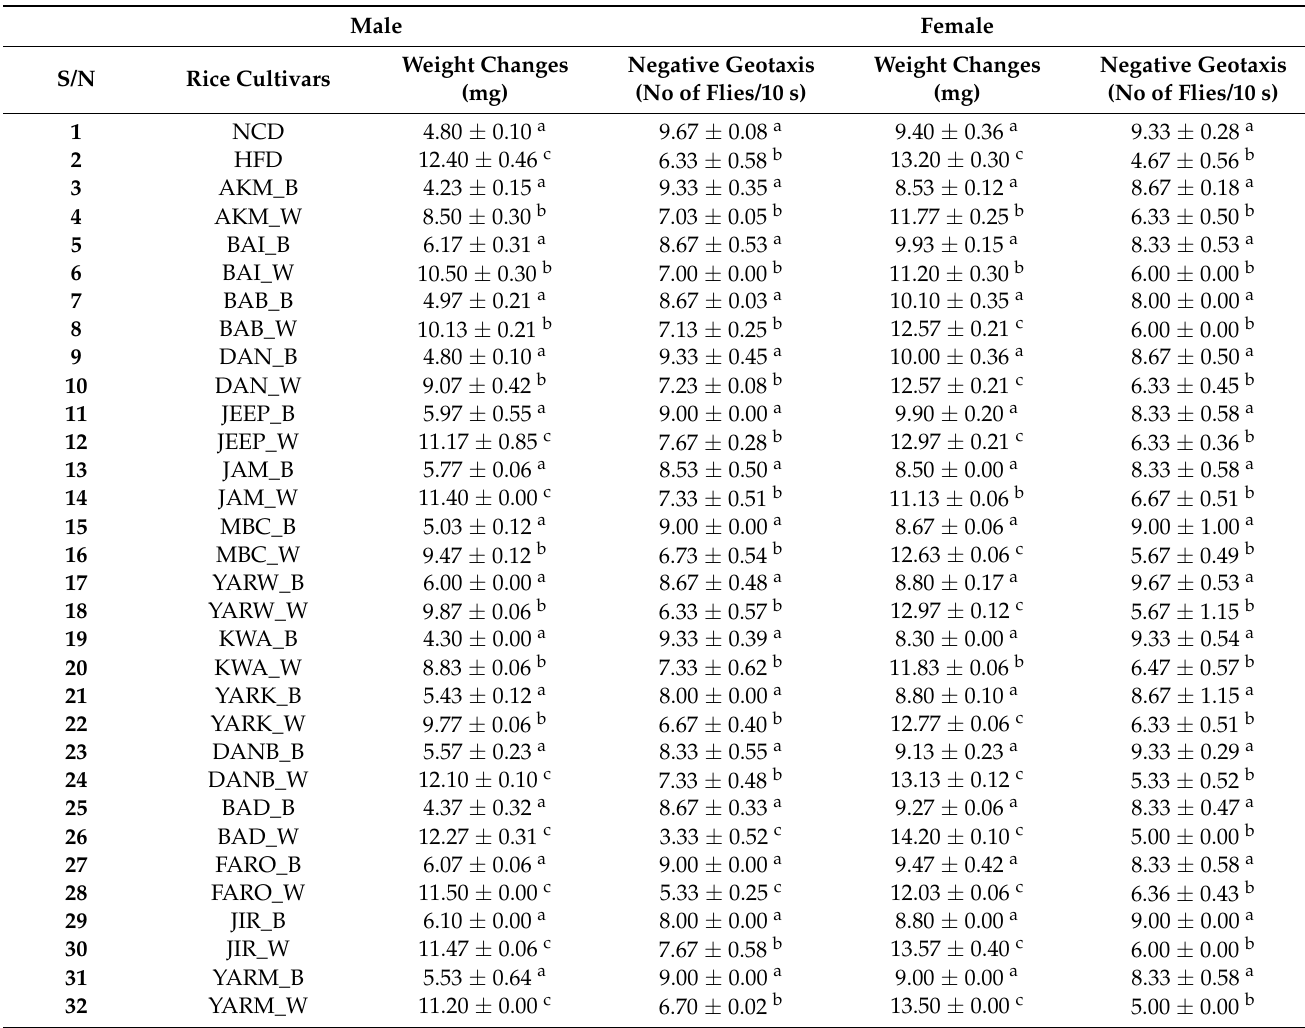
Table 3. Body weight changes and negative geotaxis for male and female flies after 7 days of diet